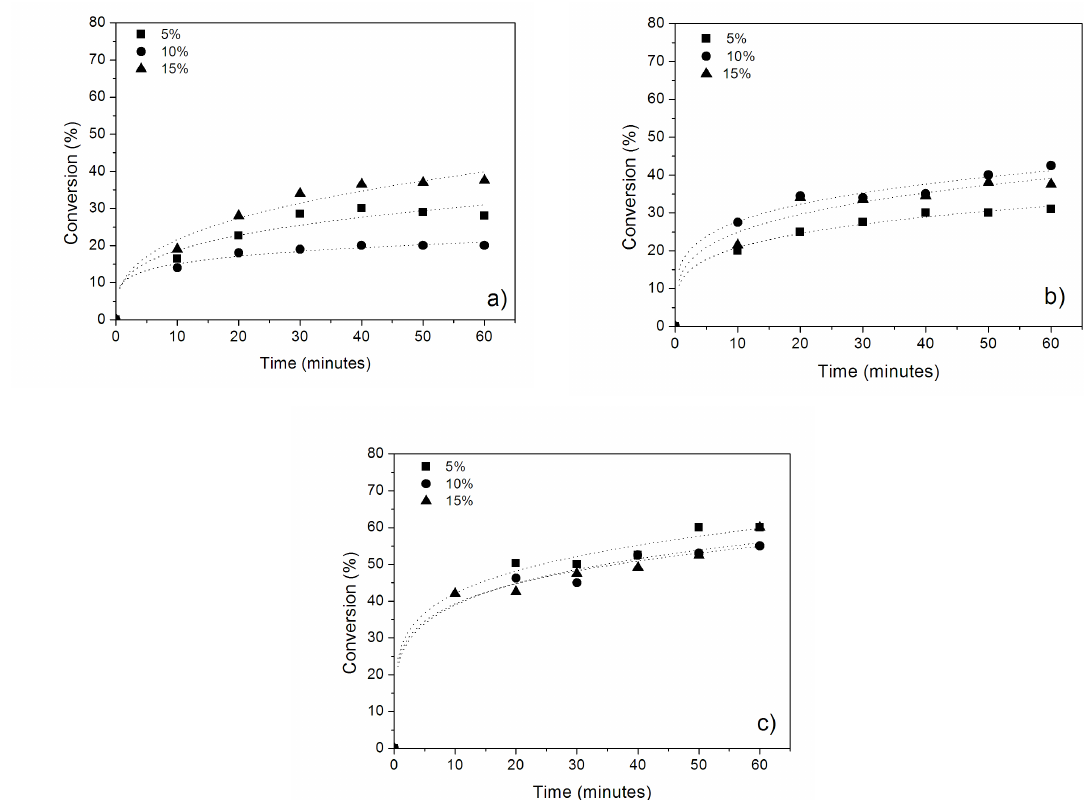
Fig. 6. Conversion as time function to ODS reactions at different titanium loadings: (a) 30ºC, b) 50ºC and c) 70ºC.